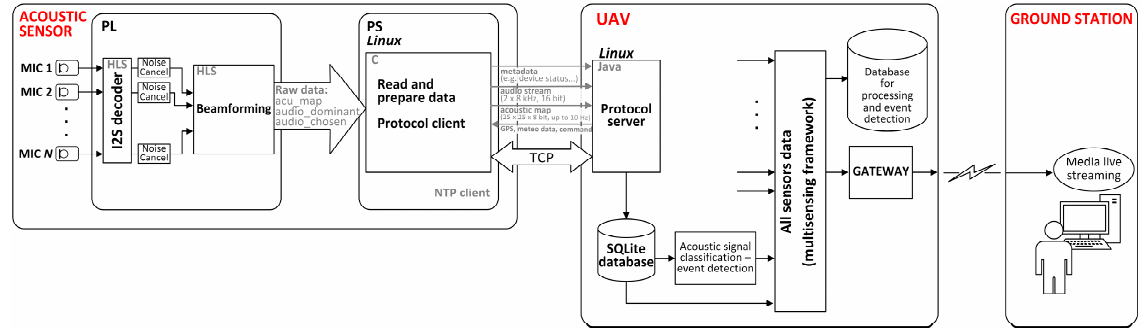
Figure 5. Software architecture of the AC.